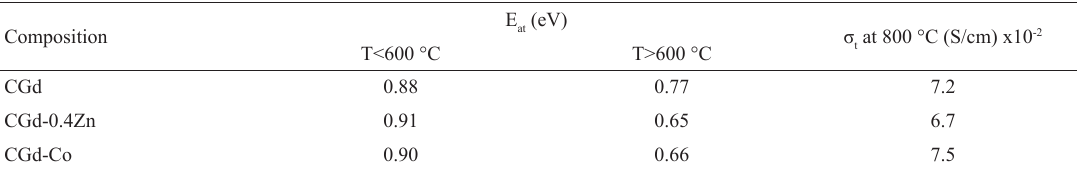
) at 800 °C and activation energies for total conductivity (E t